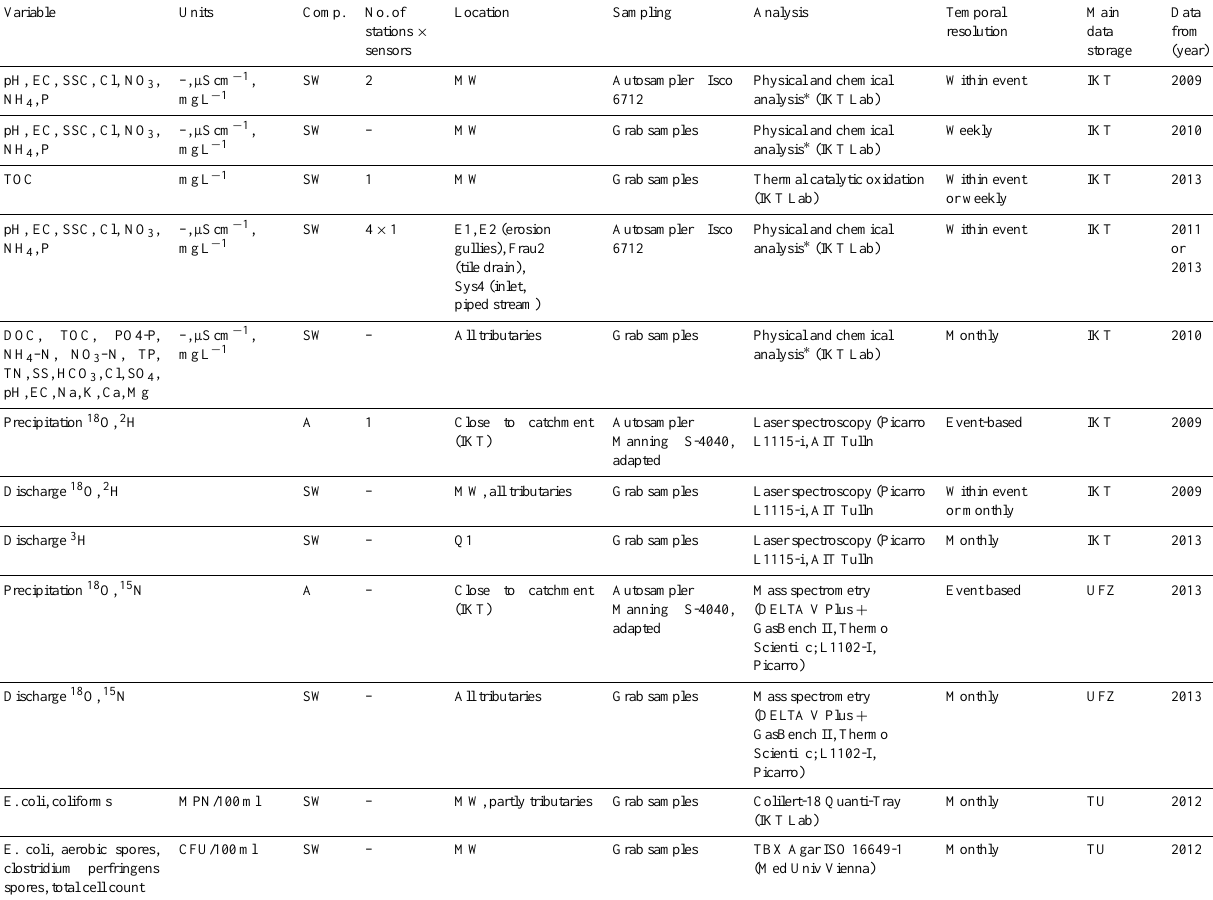
Table B2. Laboratory analyses from samples taken in the HOAL. Main data storage: IKT = IKT server (plain file system), TU = TU server, UFZ = UFZ server. ∗ Note: physical and chemical analysis (potentiometric, conductometric, filtering, ion chromatographic, photometric,